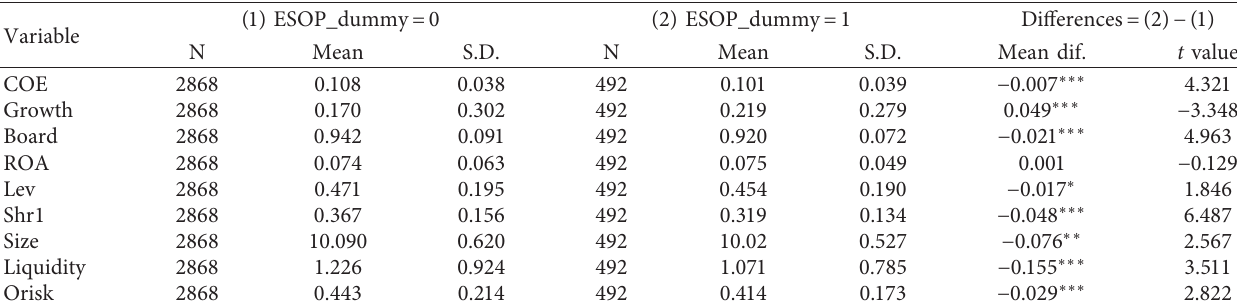
Table 2: Descriptive statistics of research variables for the grouping sample.